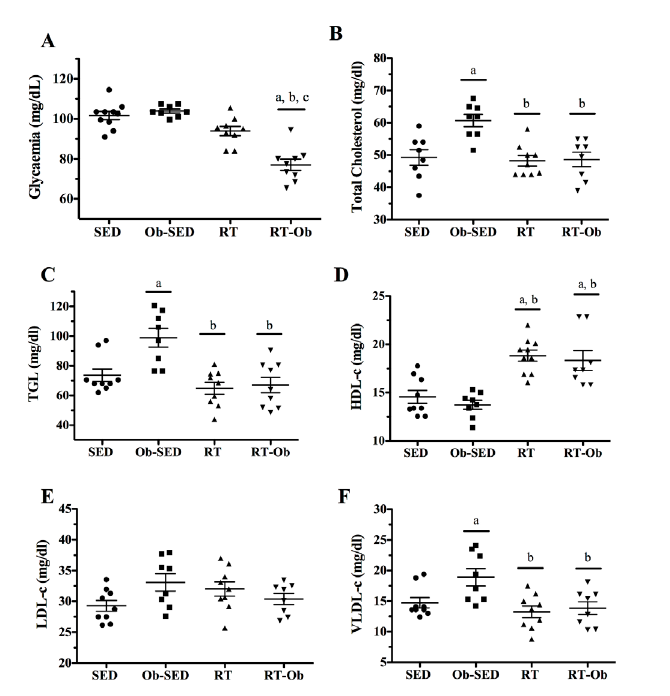
Figure 4 - Effect of high-fat diet and RT on serum: A) Glycaemia; B) Total Cholesterol; C) Triglycerides (TGL); D) High-density lipoprotein (HDL); E) Low- density lipoprotein and; F) Very low-density lipoprotein (VLDL), in mg/dL. SED, Sedentary group; Ob-SED, Obese sedentary group; RT, resistance training group; and Ob-RT, obese trained group.